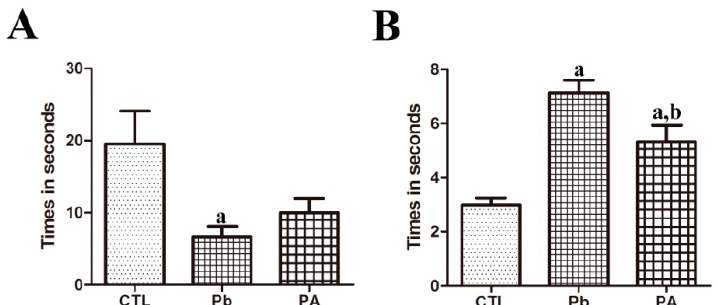
Figure 6. Effect of Pb exposure and ascorbic acid treatment in the bar holding test ( A ) and wire mesh ascending test ( B ) among offspring from CTL, Pb, and PA groups. ( A ) The times during which the animal stayed on the bar in the bar holding test. ( B ) The amount of time the animal spent to reach the top of the wire mesh in the wire mesh ascending test ( n = 12 offspring per group; a p < 0.05, indicating a significant difference compared with the control group, b p < 0.05, indicating a significant difference compared with the Pb group).